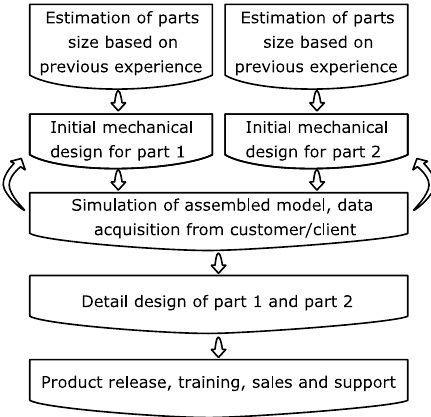
Figure 2. Dynamics data flow for the proposed concept design and detailed design steps.